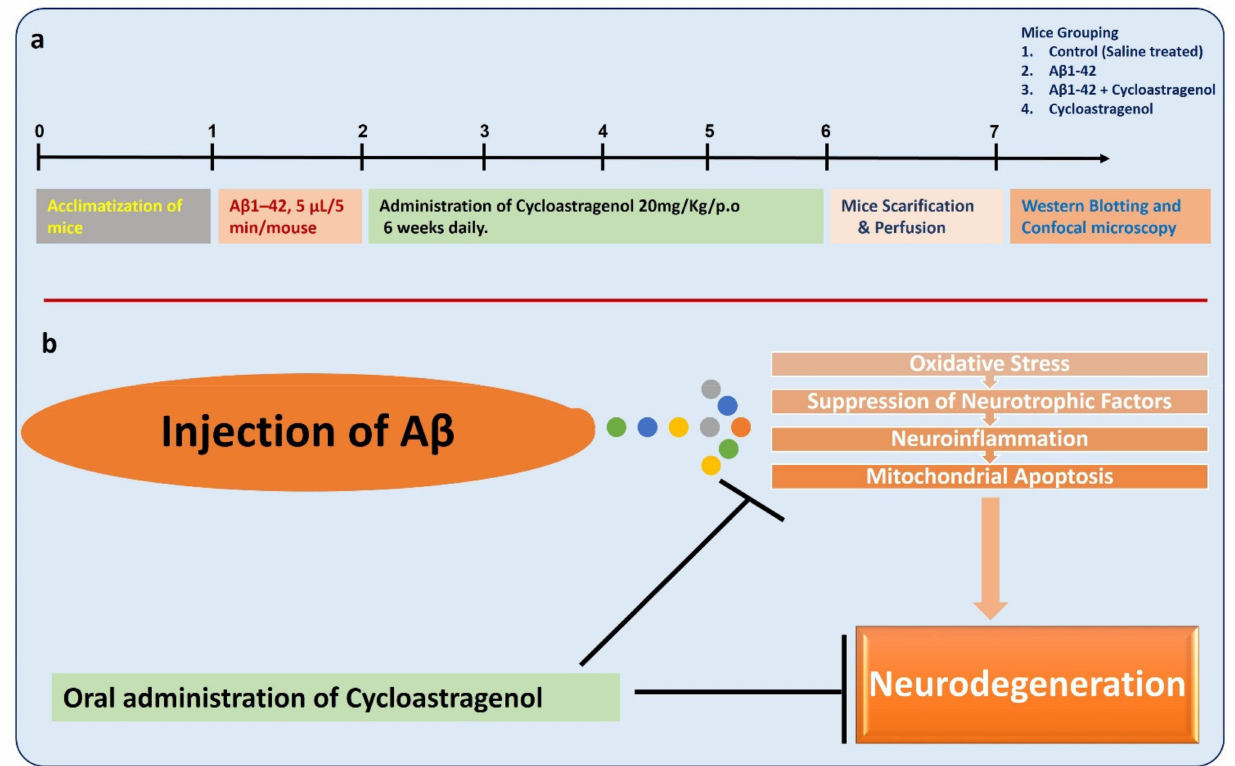
Figure 6. Study design and the graphical abstract. ( a ) Study design, showing the complete designing and regimen of the study, including mice’s treatment, grouping, doses, and experimentation. ( b ) Graphical abstract, a simple sketch showing the protective effects of cycloastragenol against the suppressed neurotrophic factors, activated MAP kinases, and the mitochondrial dysfunction in A β -injected